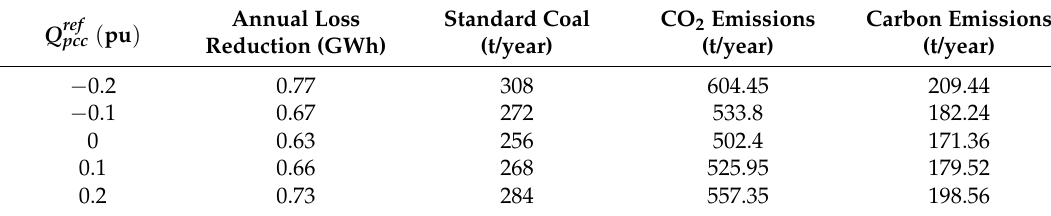
Table 3. Reductions in standard coal consumption and carbon